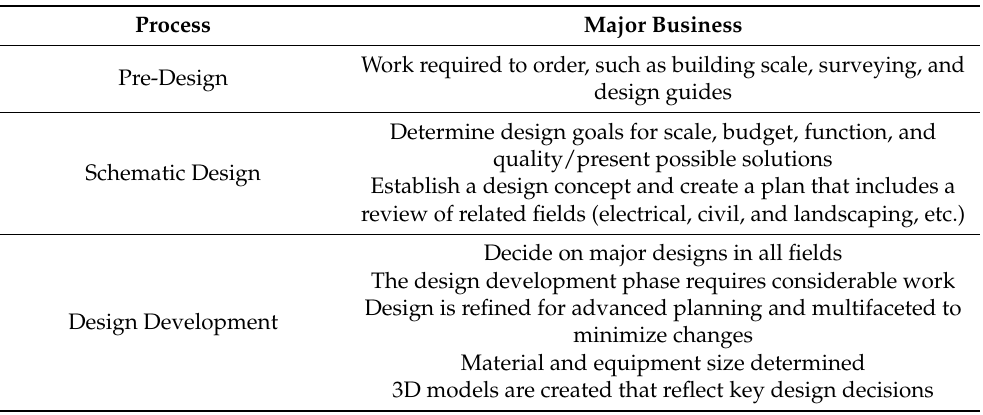
Table 2. Business by design phase using IPD-based BIM.